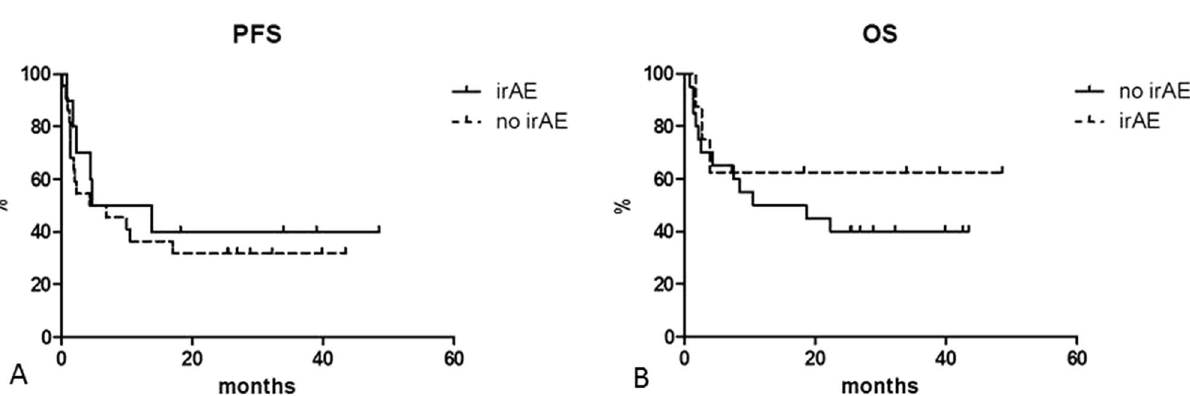
Figure 2. Progression free survival (PFS) for patients who developed an immune related adverse event (irAE) and for who did not (p = 0.5442) ( A ) and overall free survival (OS) for patients who developed an immune related adverse event (irAE) and for who did not (p = 0.4718) ( B